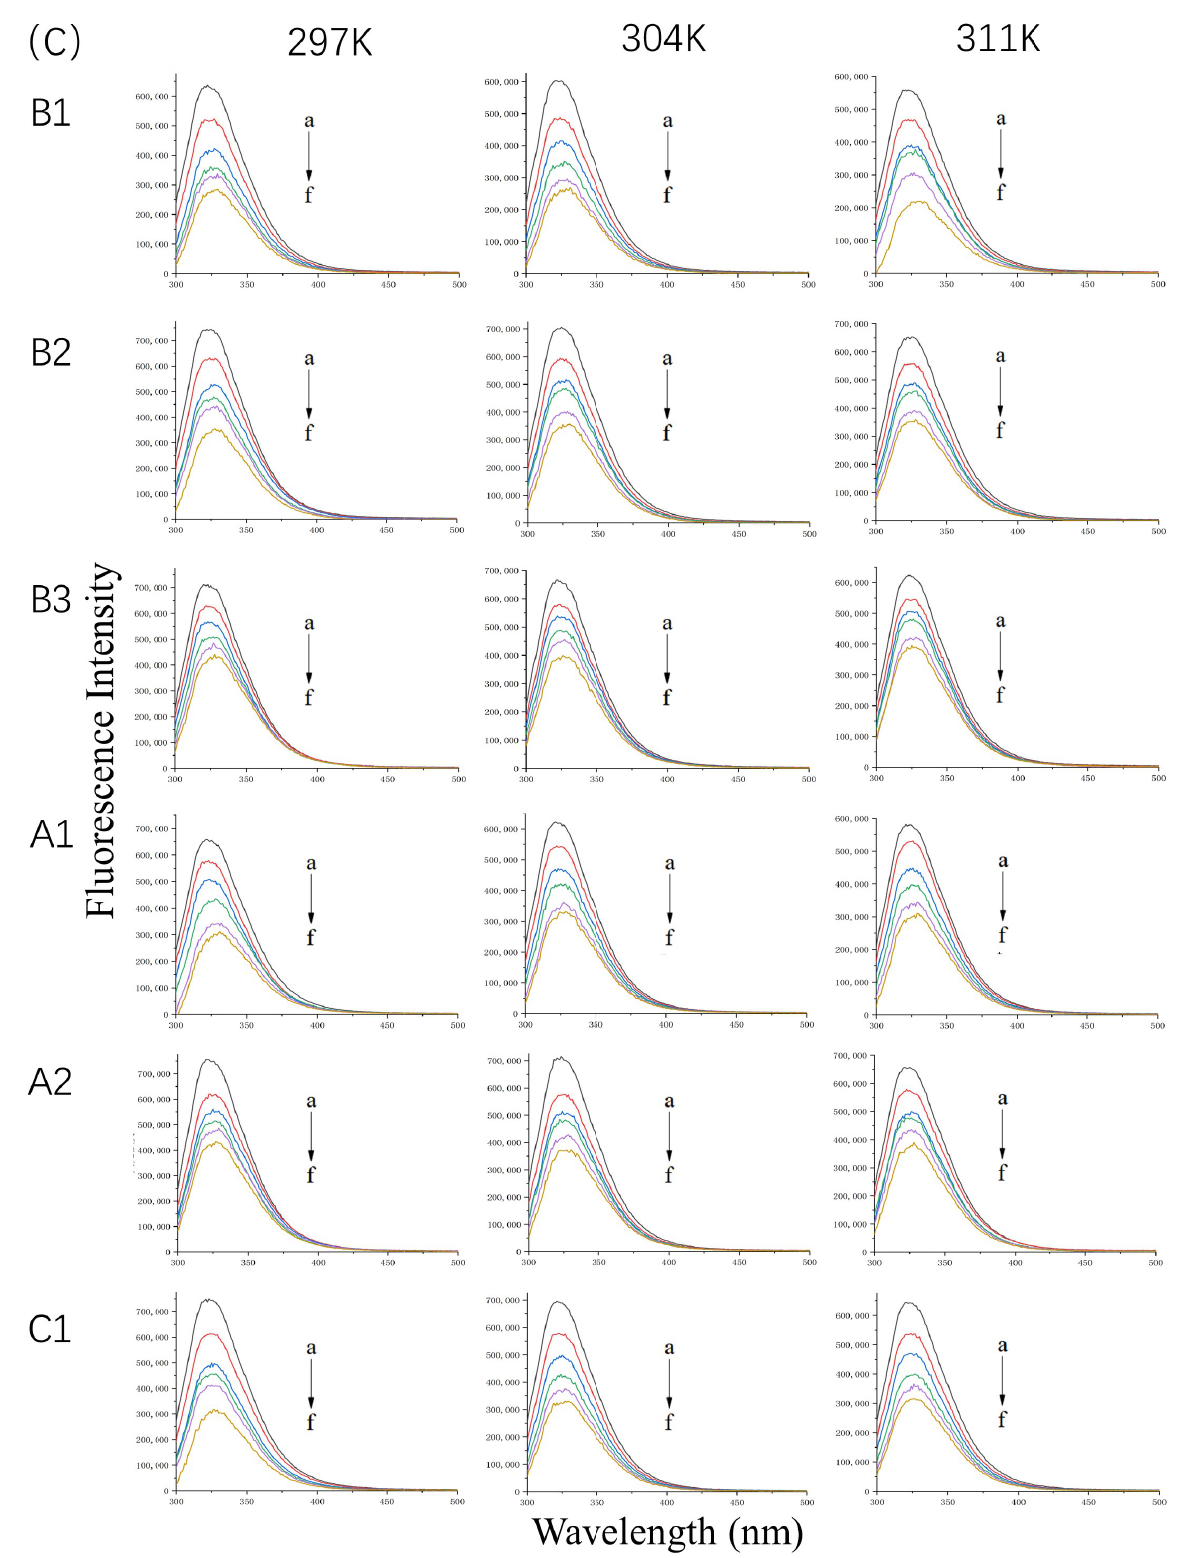
Figure 1. Fluorescence spectra of 10 µ M WP ( A ) in the presence of 0, 5, 10, 20, and 40 µ M (a–e) proanthocyanidins A1, A2, B1, B2, B3, and C1 and 20 µ M β -LG ( B ) or α -LA ( C ) in the presence of 0, 10, 20, 30, 40, and 50 µ M (a–f) proanthocyanidins A1, A2, B1, B2, B3, and C1 at 297 K, 304 K, and 311 K and pH